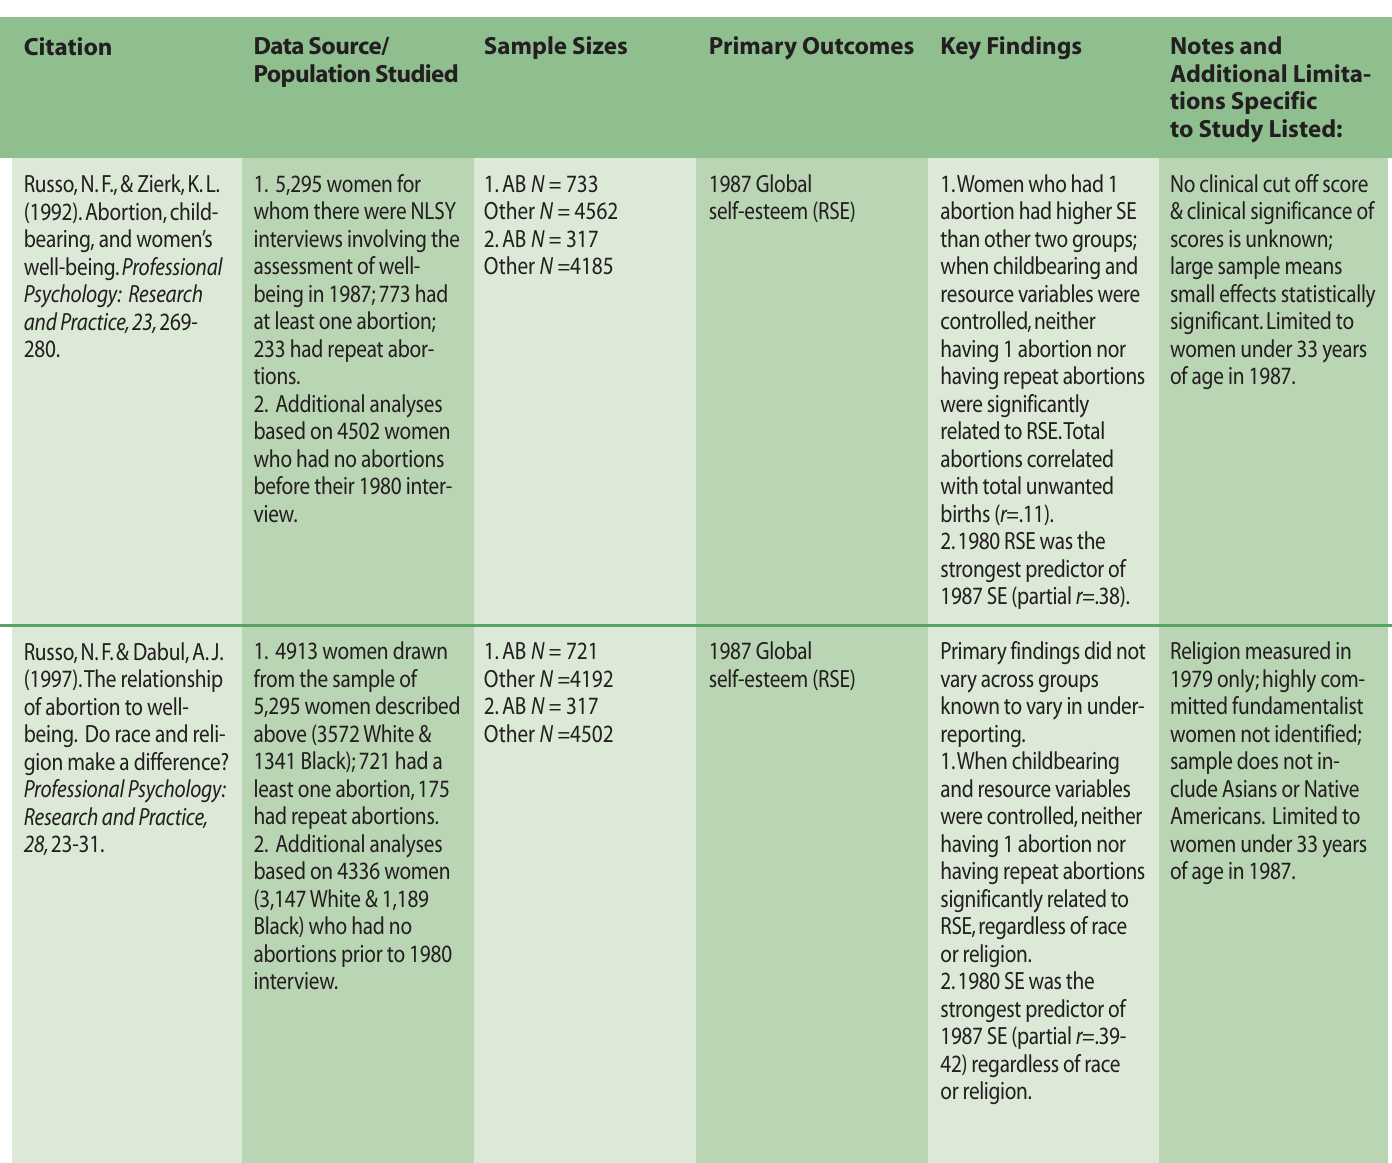
Table 1B: Secondary Analyses of Survey Data–Abortion vs.Comparison Groups U.S.STUDIES National Longitudinal Survey of Youth